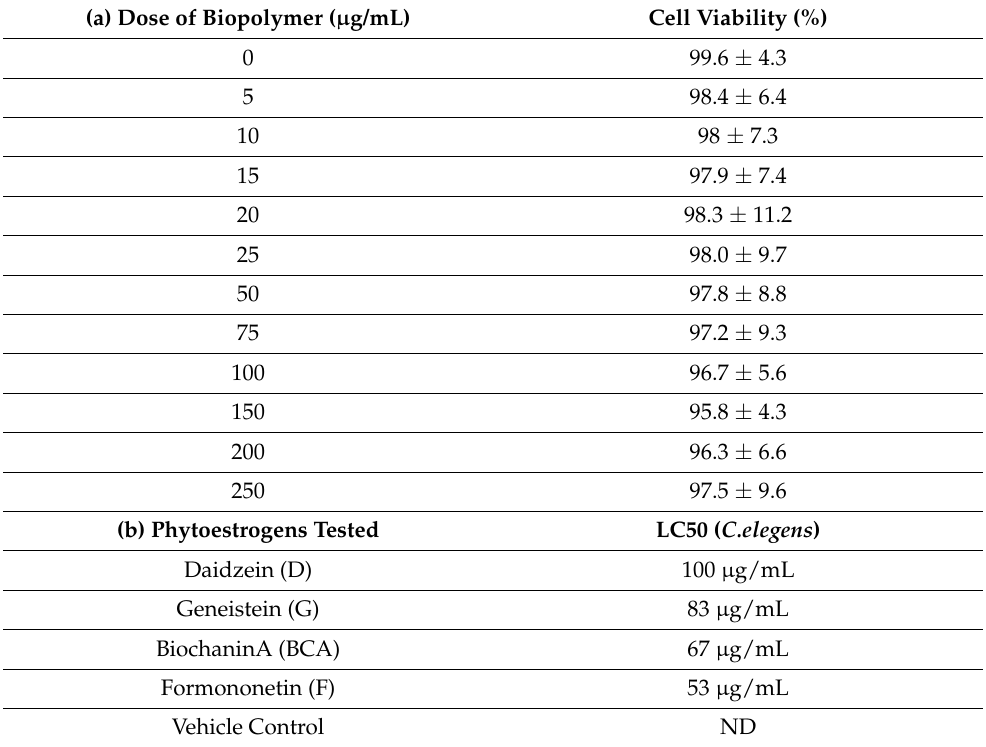
Table 3. (a) The effect of cytotoxicity of the E. hirae biopolymer on RAW264.7 cells. Cells were incubated with the purified biopolymer at doses ranging from 5 to 250 µ g/mL at 37 ◦ C for 48 h. Cell viability was measured by the MTT assay. (b) LC50 (lethal concentration) values of daidzein, genistein, biochanin A and formononetin on C. elegans after 24 h exposure. ND: Not detected Figures in parenthesis indicate the mean ± S.D ( n =